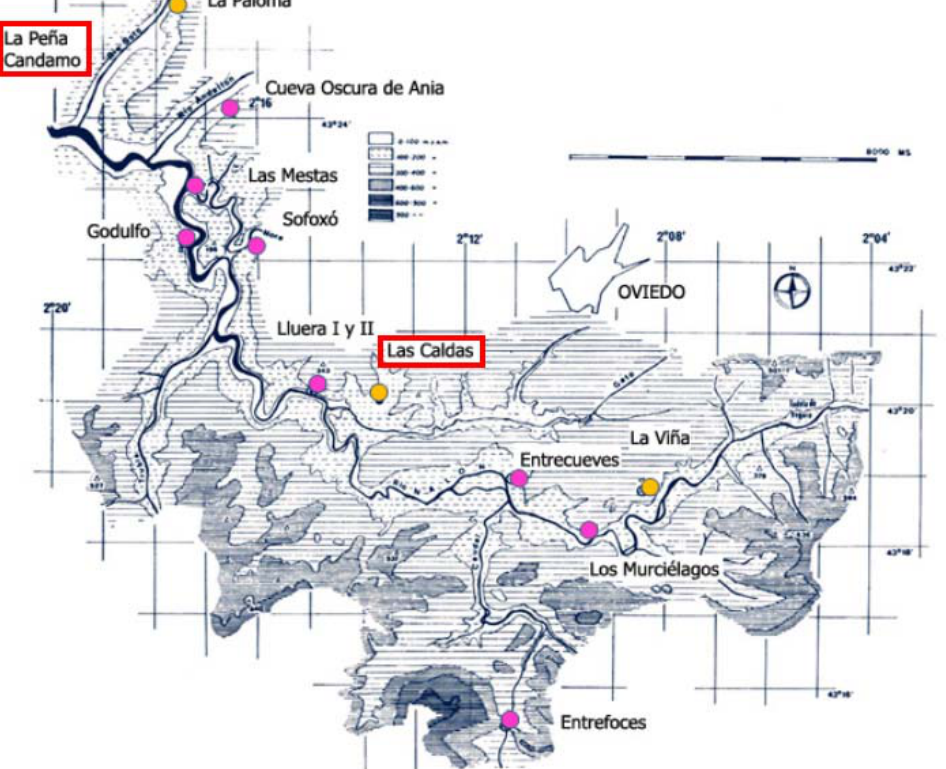
Figure 2. Location map: Nalon river middle valley. Main Paleolithic archaeological sites and rock-art